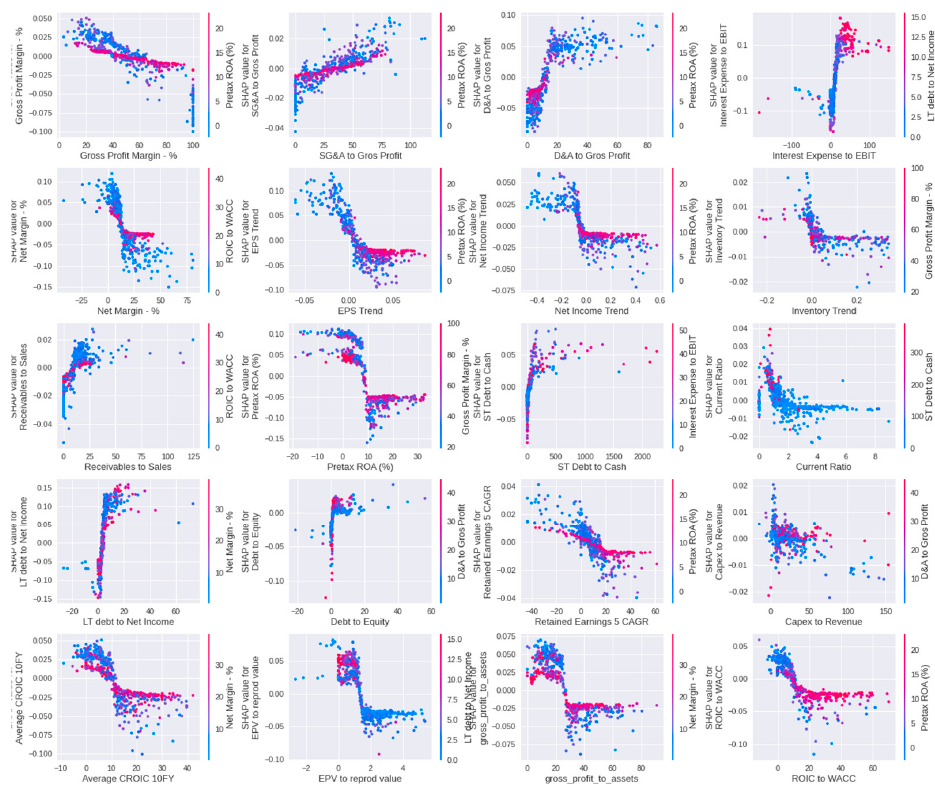
Figure A2. Dependence plot of companies with a narrow moat.